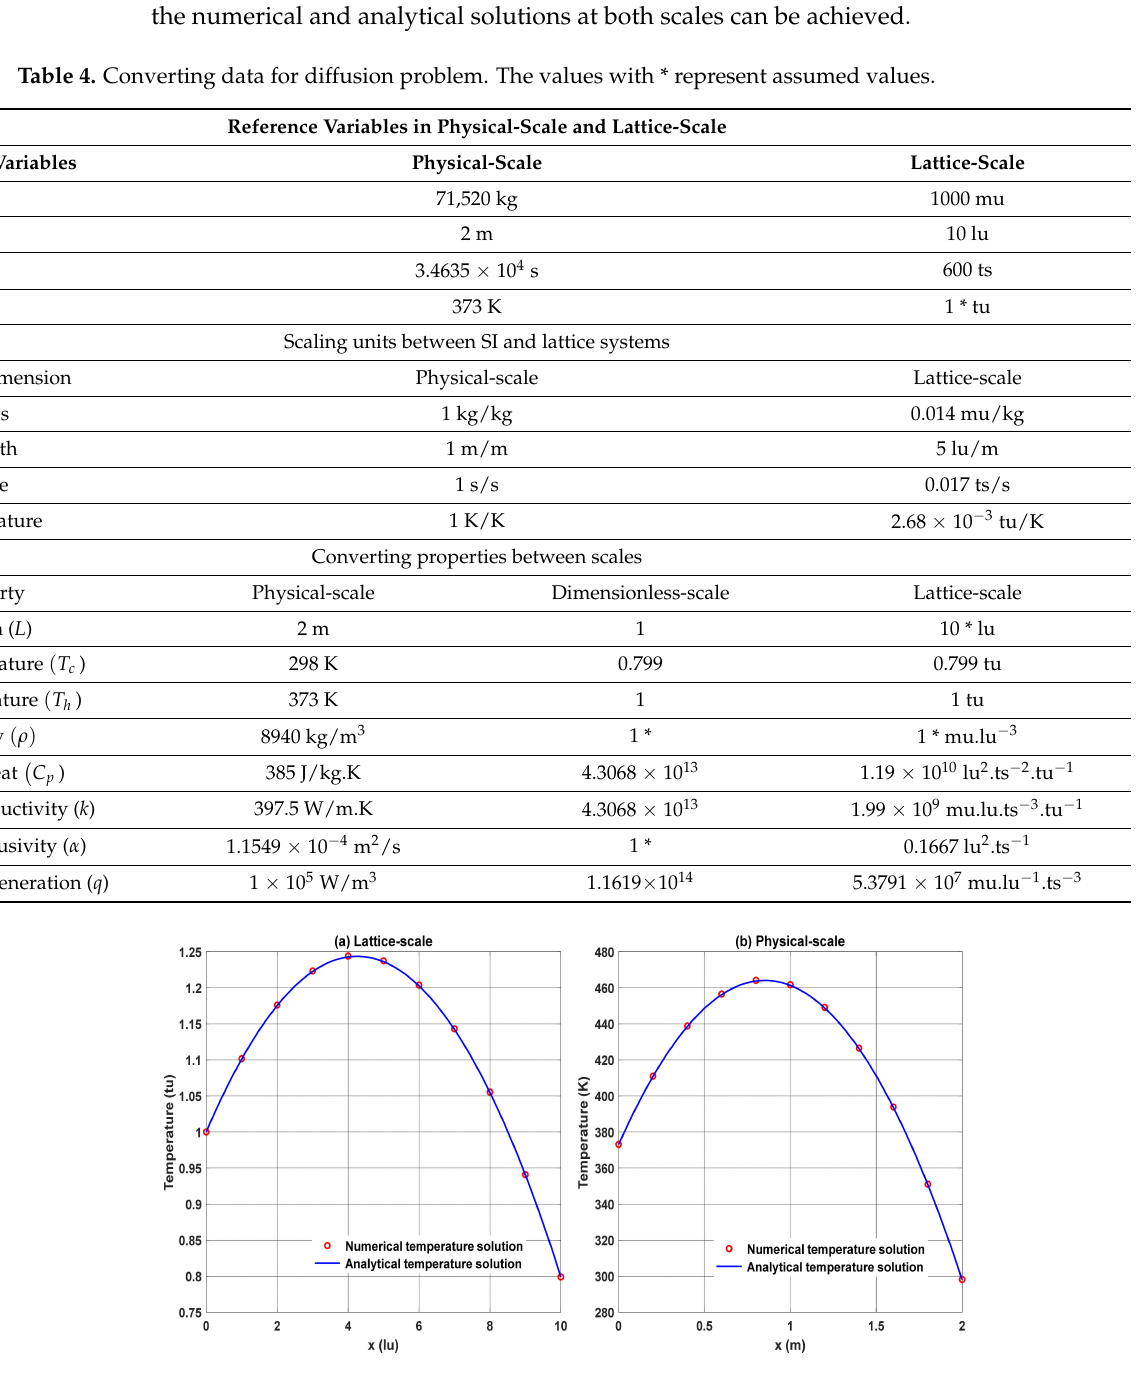
Figure 5. Numerical and analytical solutions of the steady-state temperature distribution along the rod; ( a ) solutions at the lattice-scale (the analytical solution is achieved using Equation (73) at the lattice-scale), and ( b ) solutions at the physical-scale (the numerical solution is achieved by the LBM then transformed to the physical-scale using the scaling units from Table